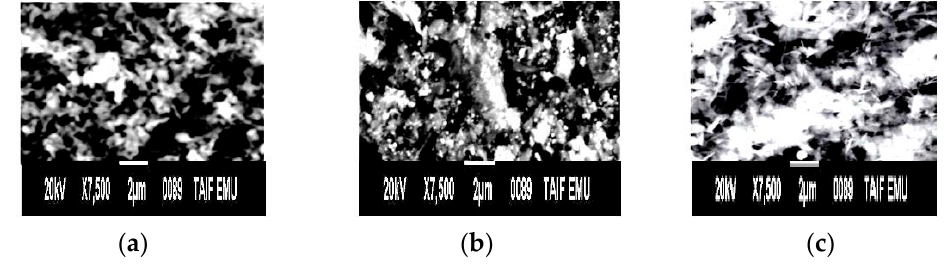
Figure 9. 1 M rGO/CuO SEM images at ( a ) room temperature, ( b ) 300 °C, and ( c ) 500 °C.